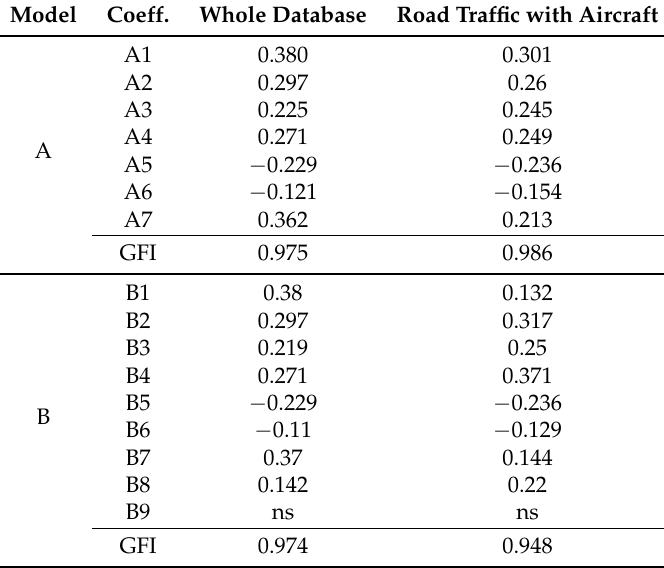
Table 5. Standardized coefficients used in models of the partial annoyance due to aircraft noise. Models are based on different samples of the French in situ survey database.